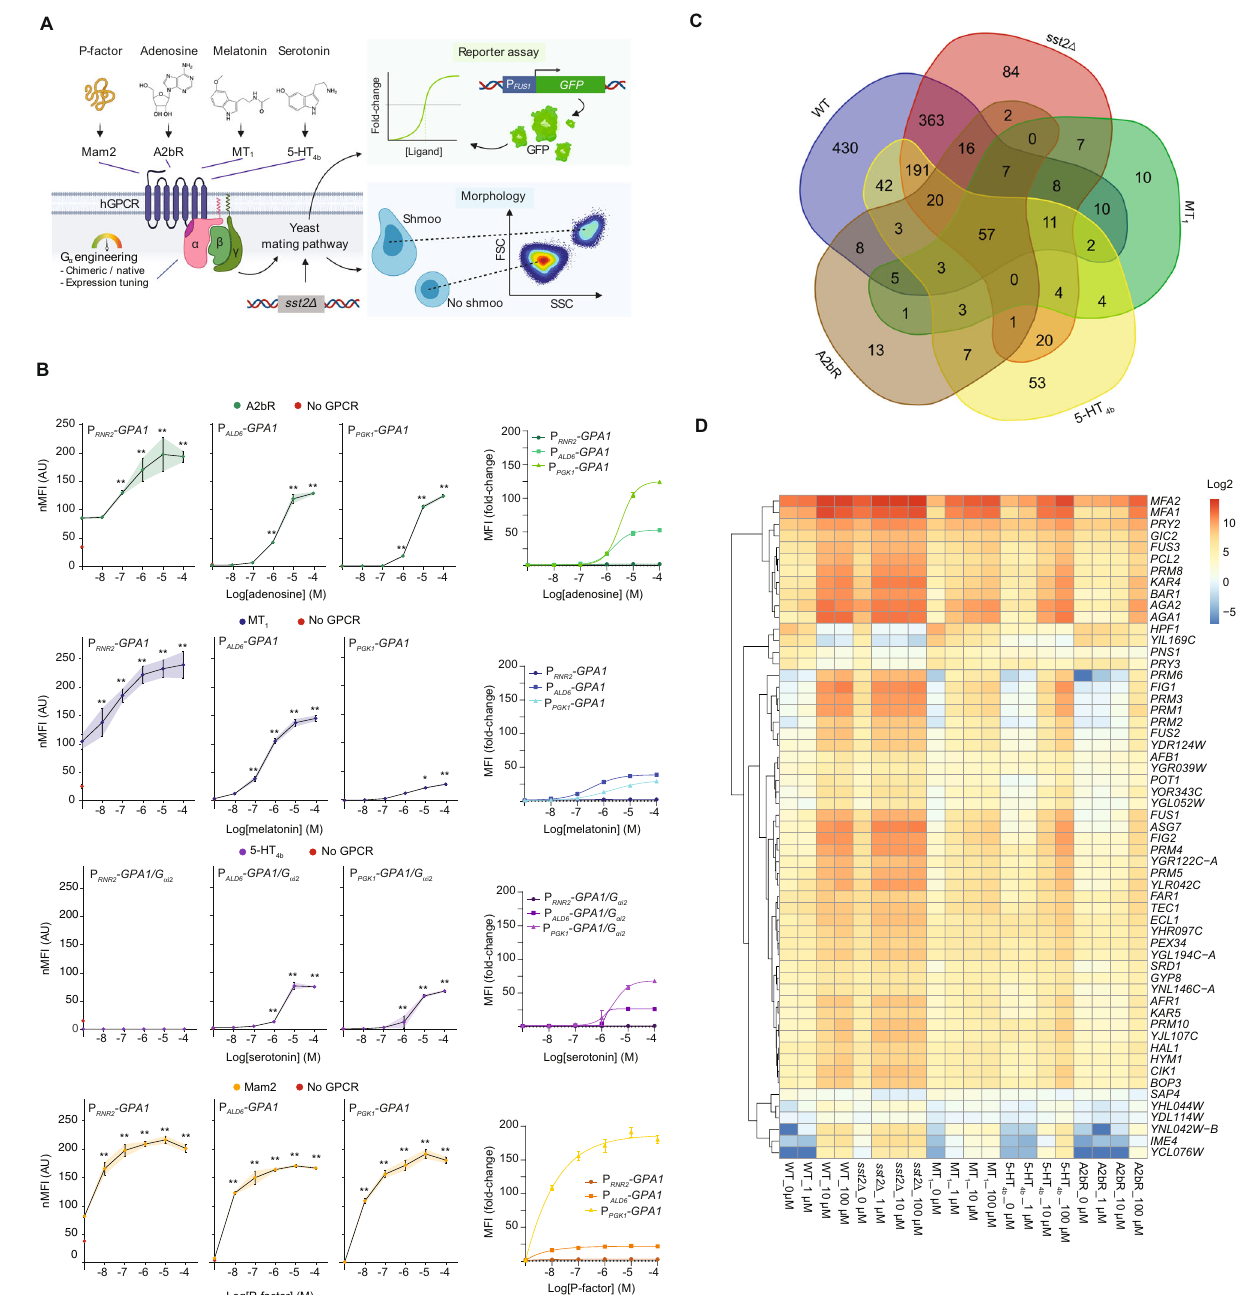
Fig. 1 | Biosensing yeast characterization and transcriptome analysis. A Sensitization of S. cerevisiae for biosensing with heterologous G protein- coupled receptor (hGPCR)-signaling via its mating pathway. S. cerevisiae strains are genetic mutants for sst2 Δ to diminish inhibition of signal transduction mediated by G βγ subunits. G α expression tuning controls background and ligand-activated signal transduction schematized as fold change of GFP expressed from the P FUS1 - GFP reporter ( “ Reporter assay ” ). The yeast shmoo phenotype ( “ Morphology ” ), following from mating pathway activation, can be observed as increased forward-scatter (FSC) and side-scatter (SSC) with fl ow cytometry. B Normalized median fl uorescence intensities (nMFI, left) and MFI fold-changes (right) for biosensing yeast strains expressing A2bR, MT 1 , 5-HT 4b , or Mam2 (CPK153-161 and CPK165-167) are shown for low (P RNR2 ), medium (P ALD6 ), and strong (P PGK1 ) G α subunit expression with or without cognate ligands in dosage range 0 – 100 µ M shown as log[M]. Parental strains without GPCRs or ligand supplementation (CPK131-136) are shown as red circles (left). nMFI is normalized for all strains to the P PGK1 - G α strain without ligand